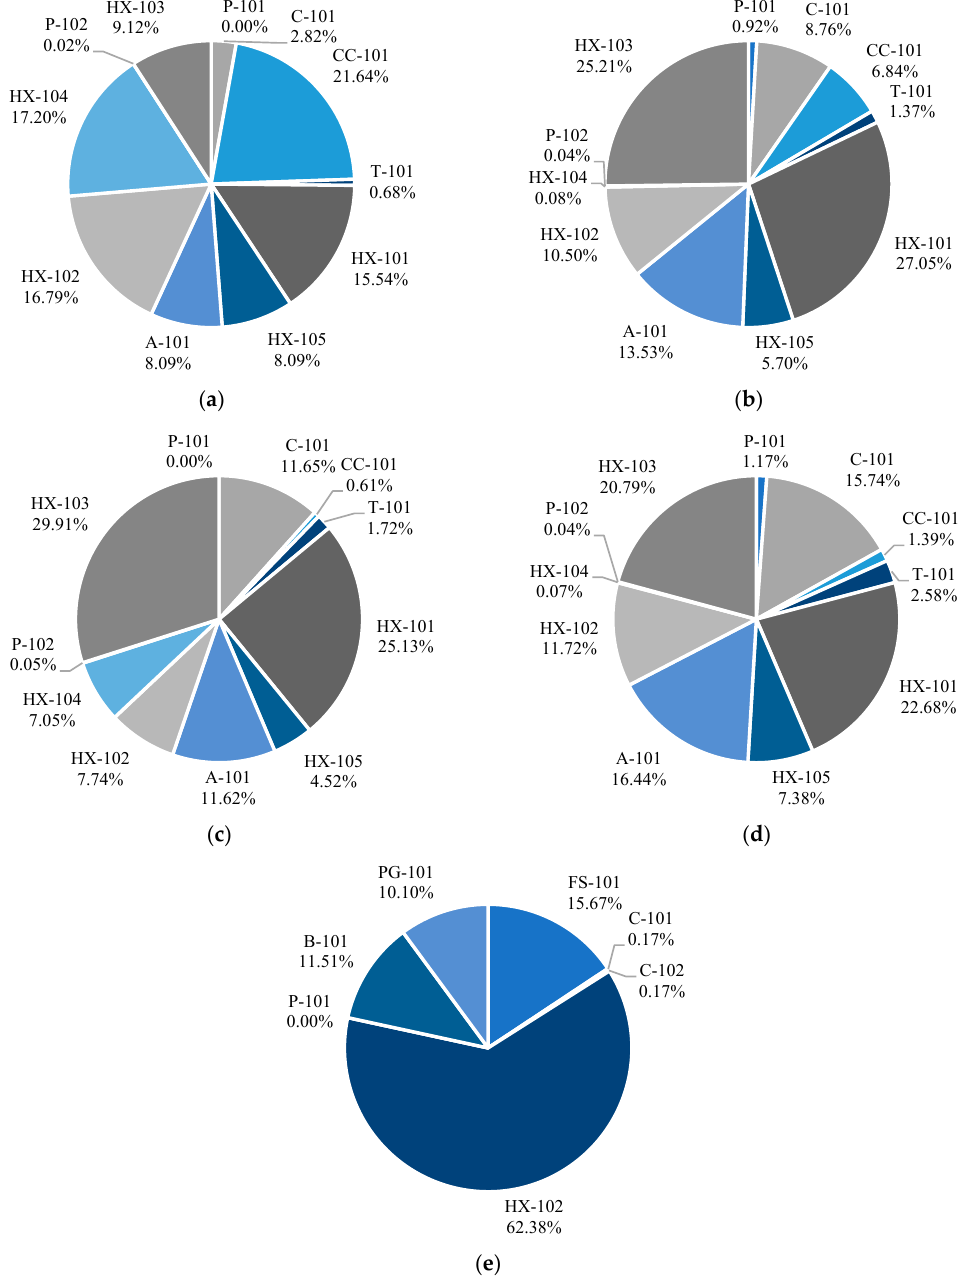
Figure 6. Exergy destruction cost rate of the CCHP system at a component level based on: ( a ) Fuel oil No. 6, ( b ) Natural gas, ( c ) Biomass, ( d ) Syngas, and ( e ) Base case.